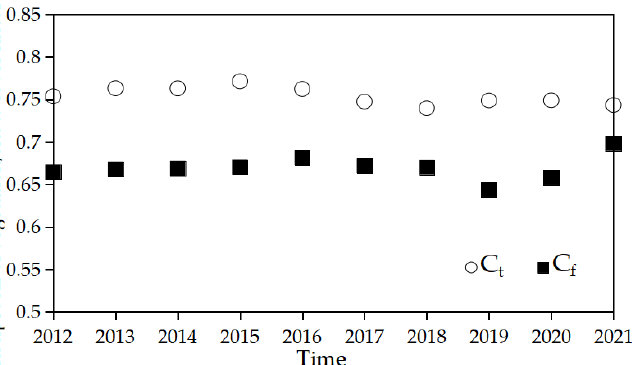
Figure 5. Reciprocals of vegetation and snow cover factors, C t and C f , for the period from 2012 to 2021.